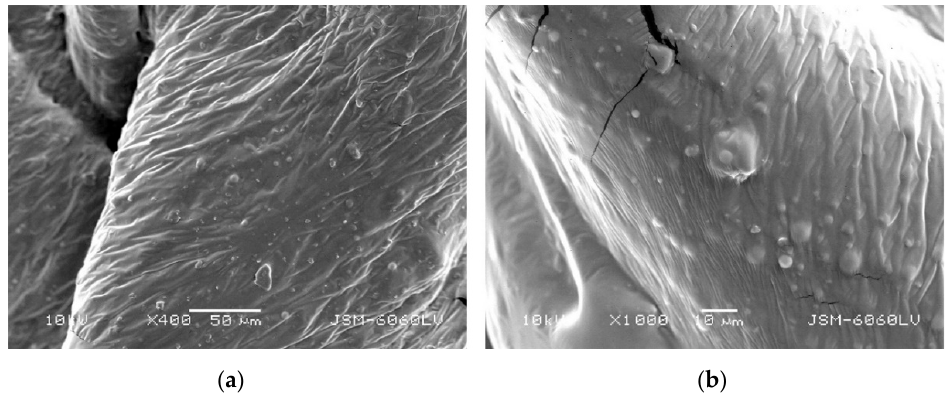
Figure 1. Transparent base, mag. ( a ) 400× and ( b ) 1000×.